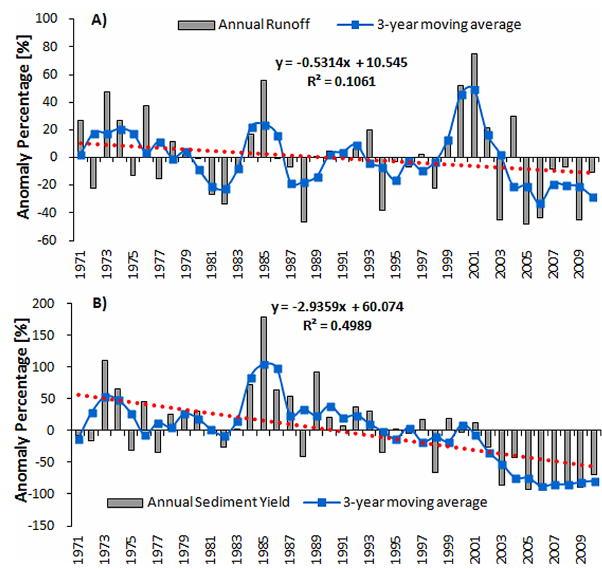
Figure 2. The trend and the inter-annual variability of annual runoff and suspended sediment yield in the Kejie watershed (1971–2010).